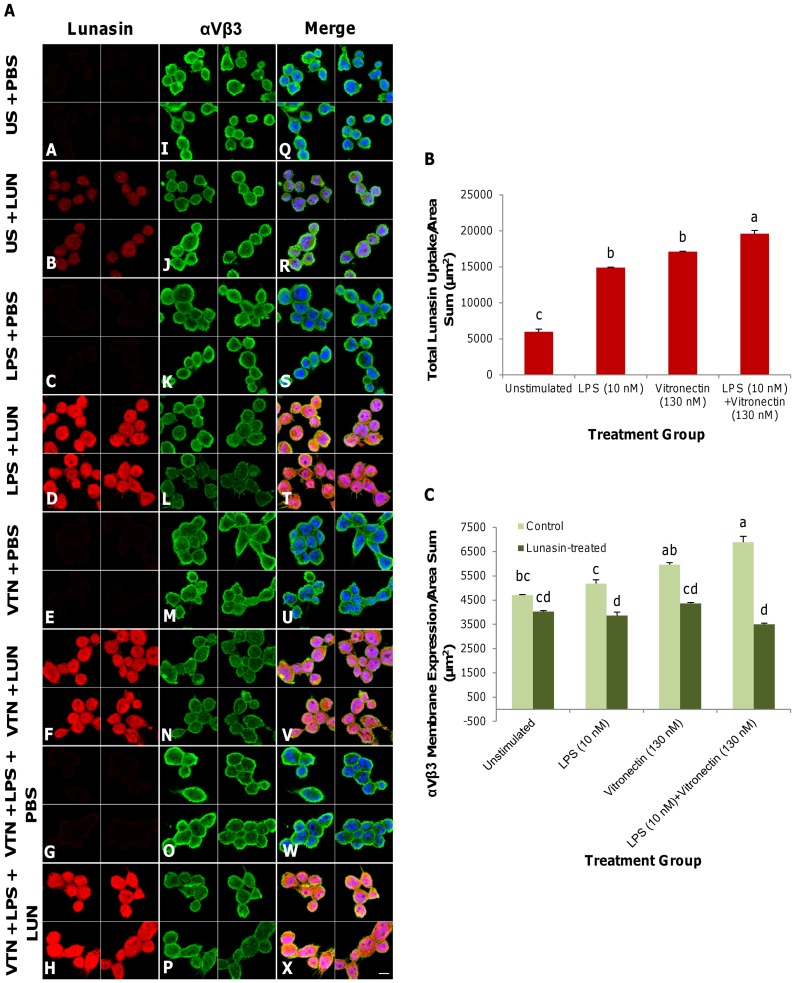
Lunasin reduced αVβ3 integrin membrane expression initially upregulated by inflammatory ligands.Two-dimensional optical planes demonstrate the immunocytochemical localization of lunasin (red), αVβ3 integrin (green) and nuclei (blue) (
Figure 1A
). Unstimulated macrophages or macrophages have been induced with LPS (10 nM), vitronectin (130 nM) or the two molecules in combination for 24 h and treated with lunasin (1 µM) for 1 h. Compared to the PBS control (A–B), lunasin uptake increased sequentially upon stimulation with LPS (C–D), vitronectin (E–F), or both molecules in combination (G–H). Lunasin (1 µM) treatment reduced the basal expression level of αVβ3 integrin at the cellular membrane (I–J). The upregulation of the total basal expression level of αVβ3 integrin at the membrane in the presence of LPS (K–L), vitronectin (M–N) or both molecules in combination (O–P) was subsequently attenuated by lunasin treatment (1 µM). The merged image (with nuclei) shows increased lunasin uptake and a concomitant reduction in the level of αVβ3 integrin expression at the surface of the plasma membrane (Q–X), as well as their respective expression levels (
Figure 1B, 1C
). Four independent fields of view from three independent cellular replicates were merged together per treatment group. In Figure 1B and 1C, the data represent the average of triplicates or quadruplicates ± SE. Means with different letters are significantly different from each other (n = 3, p<0.05). US  =  unstimulated, PBS  =  phosphate-buffered saline, LPS  =  lipopolysaccharide (10 nM), VTN  =  vitronectin (130 nM), LUN  =  lunasin (1 µM). Bar  = 10 µm.